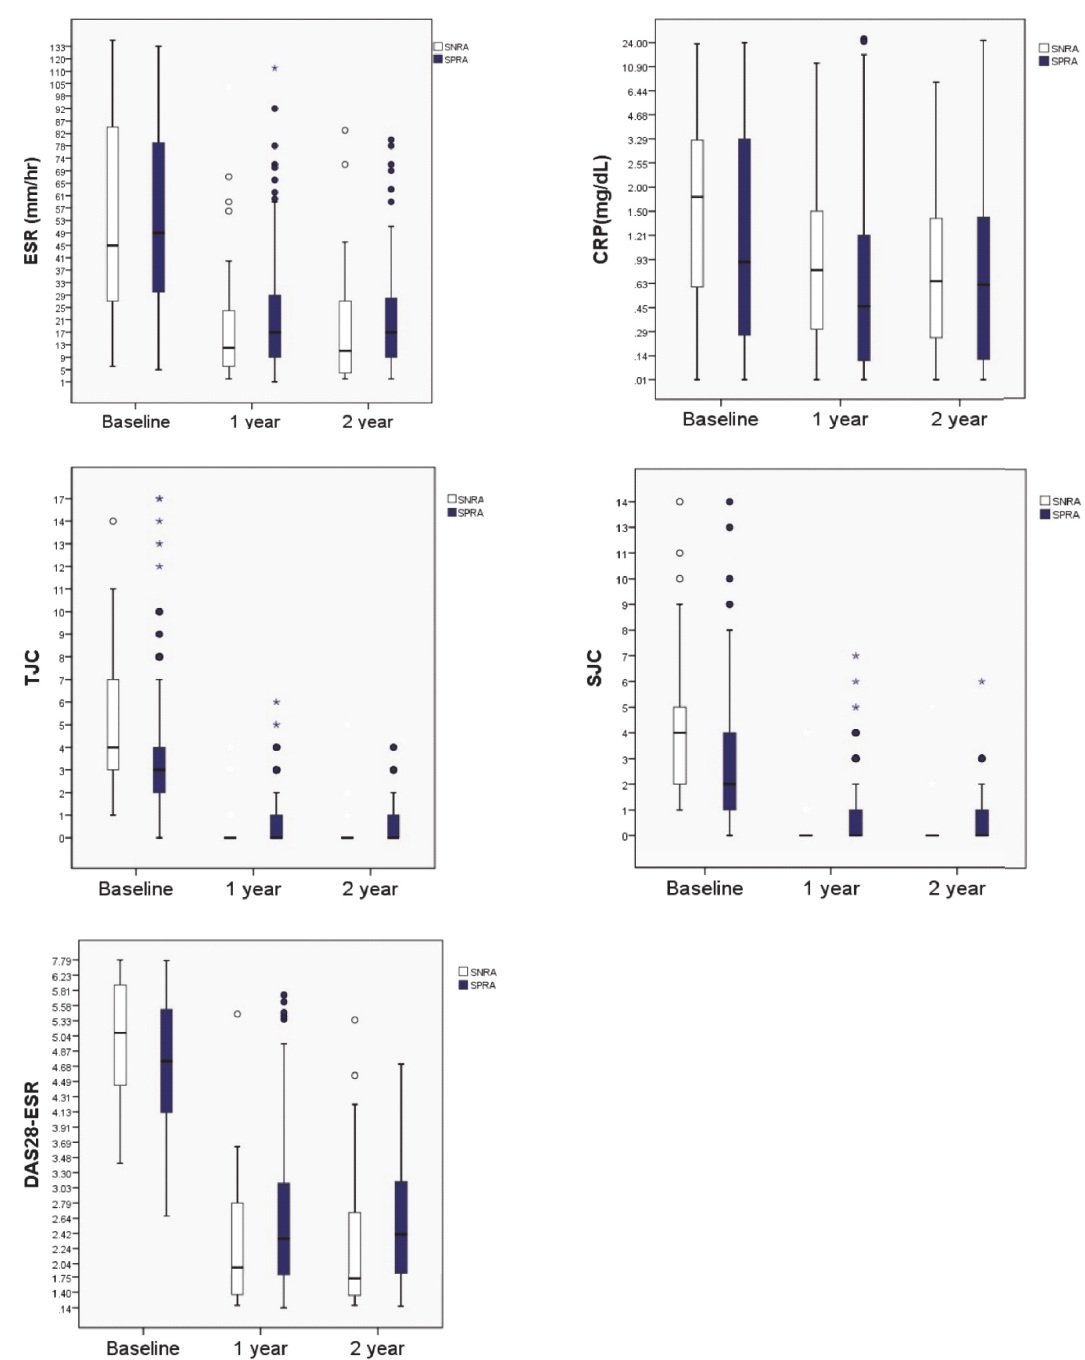
Fig 1. Flow diagram of the study design. used to compare continuous variables with non-normal distribution. The Chi-square test was used to assess the association between categorical variables. Disease activity measures evalu- ated over a 2-year period were compared by linear mixed model. In all the analyses, a p value of < 0.05 was considered to be statistically significant.